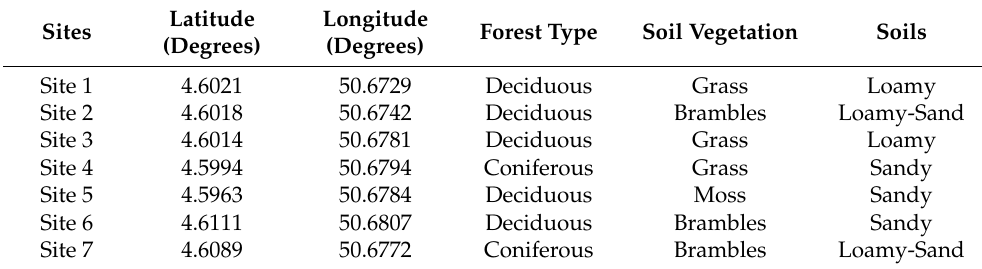
Table 1. Characteristics of the seven sites